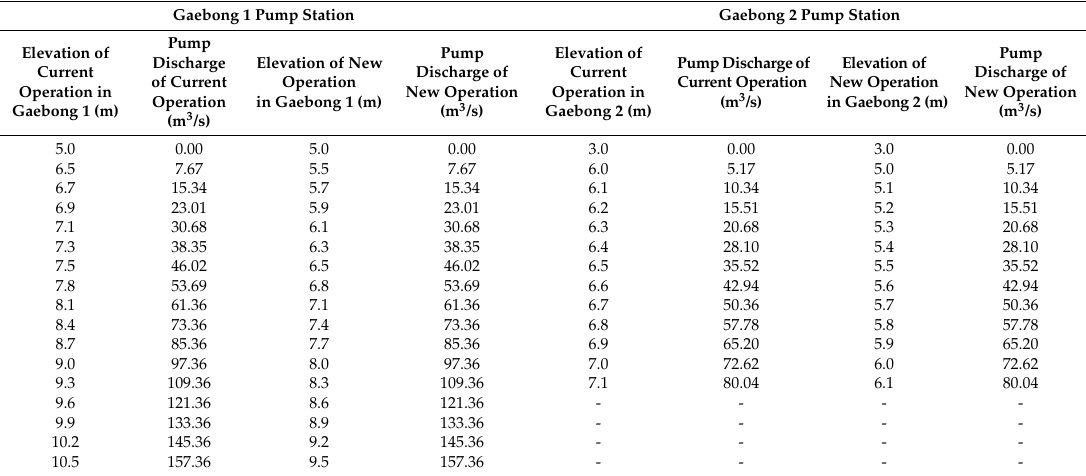
Table 1. Current and new operations of the drainage pumps in the centralized reservoirs.